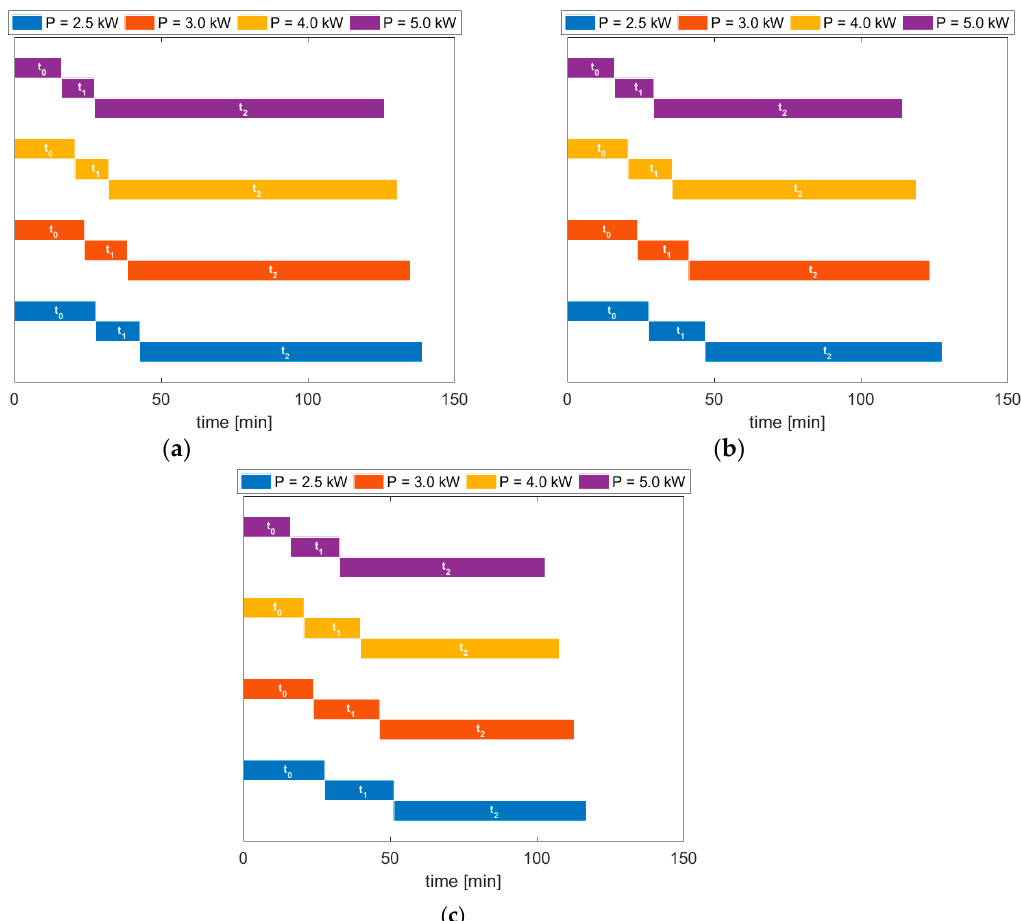
Figure 8. Required time for the HTC process to produce the 95% of the target hydrochar mass (i.e. 0.95 · F HC ) . ( a ): T = 260 C; ( b ): T = 280 C; ( c ): T = 305 C. For each power input case, the process time is subdivided into three stages: initial no-reaction phase ( t 0 ) , heating-up phase with increasing reaction rate ( t 1 ) , and reaction phase at constant operating temperature ( t 2 ) .